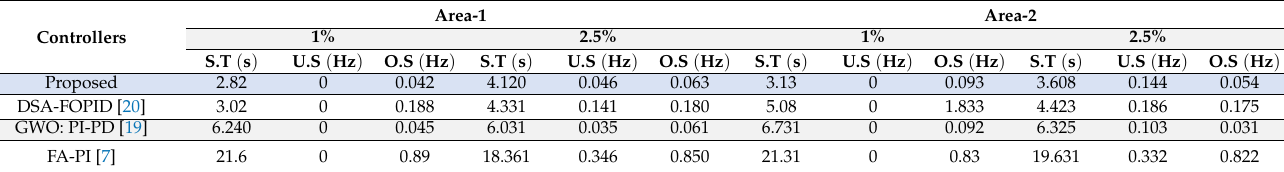
Table 3. Response of controllers in area-1 and area-2 at 1% and 2.5%. Table 3 . Response of controllers in area-1 and area-2 at 1% and 2.5% .